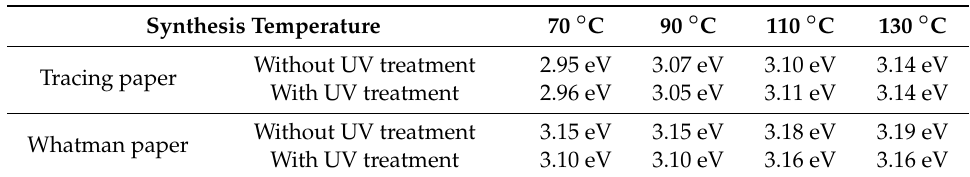
Table 1. Optical band gap of ZnO nanorods, produced with different synthesis time and temperature, obtained by extrapolating ( α h ν ) 2 vs. h ν .